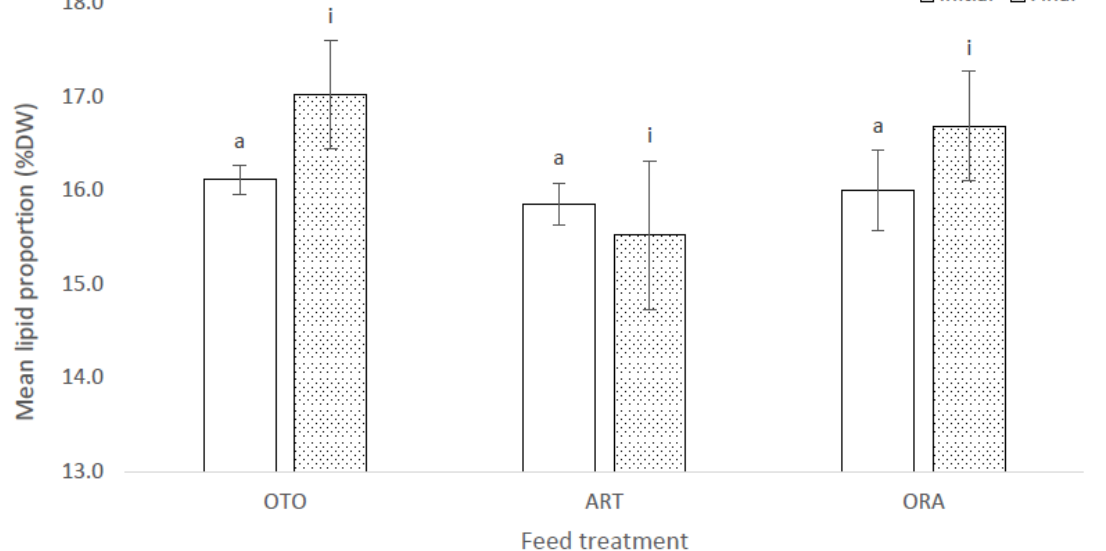
Figure 5. Mean proportional lipid content of larval giant kōkopu as a percentage of dry weight (DW) for at the initial and final sampling events for three different feed treatments; i.e., OTO (Otohime), ART (Artemac) and ORA (O.range) (mean ± SE). Means with different superscripts are significantly different within each of the set of three treatment means for each sampling event ( p < 0.05).